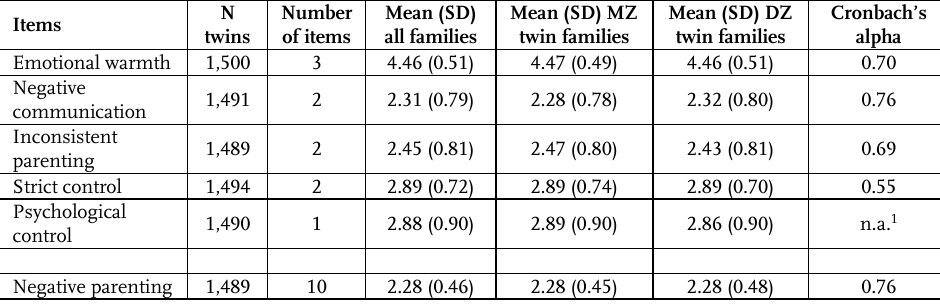
Table 3 : Overview parenting dimensions (analytical sample) N Items